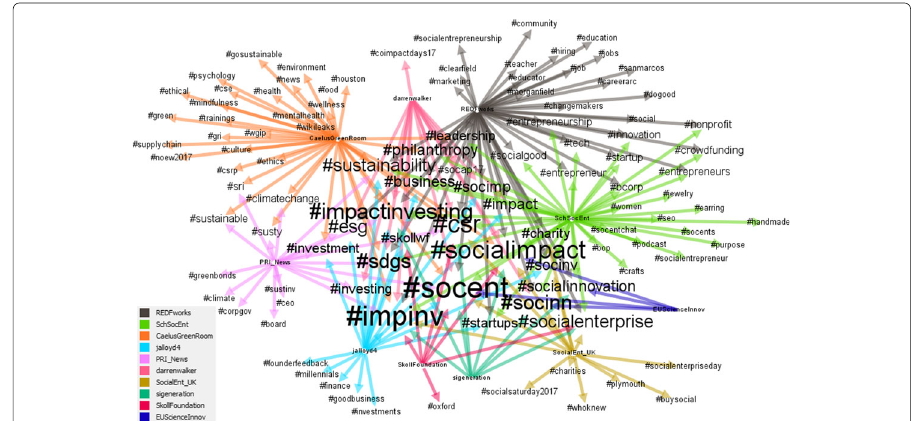
Fig. 6 A bipartite network of the retweet communities and hashtags. The retweet communities are denoted by colors (bottom-right inset) and identified by the most influential users. Shown are hashtag used at least 500 times